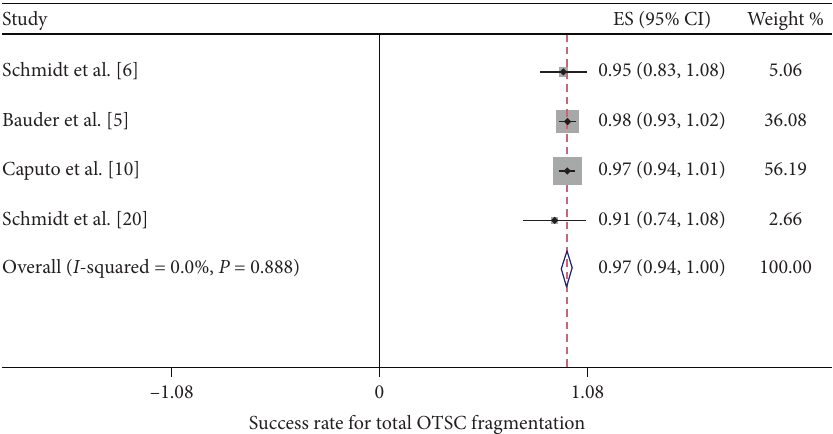
Figure 3: The pooled success rate for OTSC fragmentation by the remOVE system.